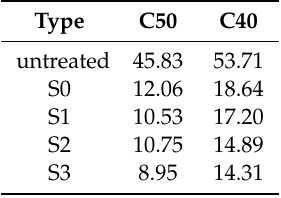
Figure 6. Effect of SiO 2 sol/silane emulsion with different programs on chloride profiles in concrete: ( a ) C50; ( b ) C40.